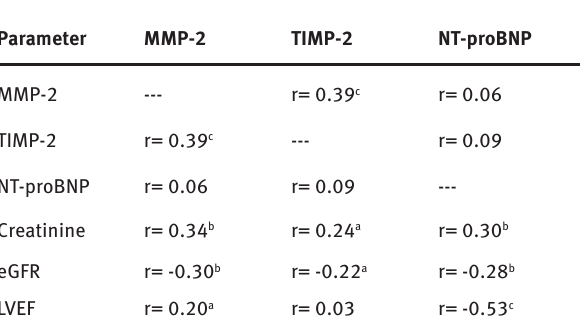
Table 6: The correlations between analyzed parameters in all patients